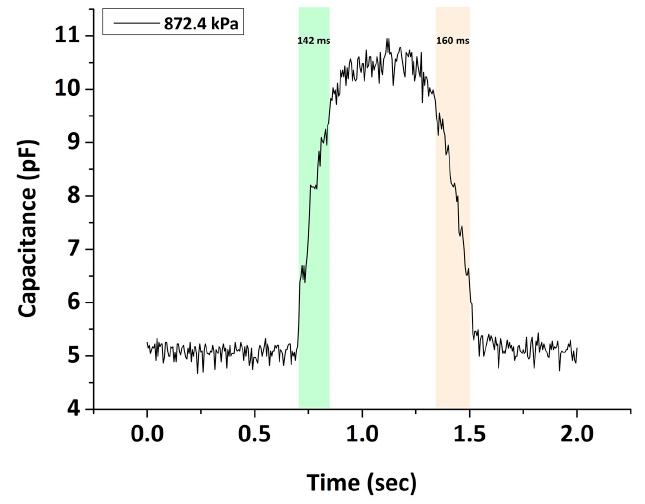
Figure 10. Sensor response and recovery times under an applied pressure of 872.4 kPa.